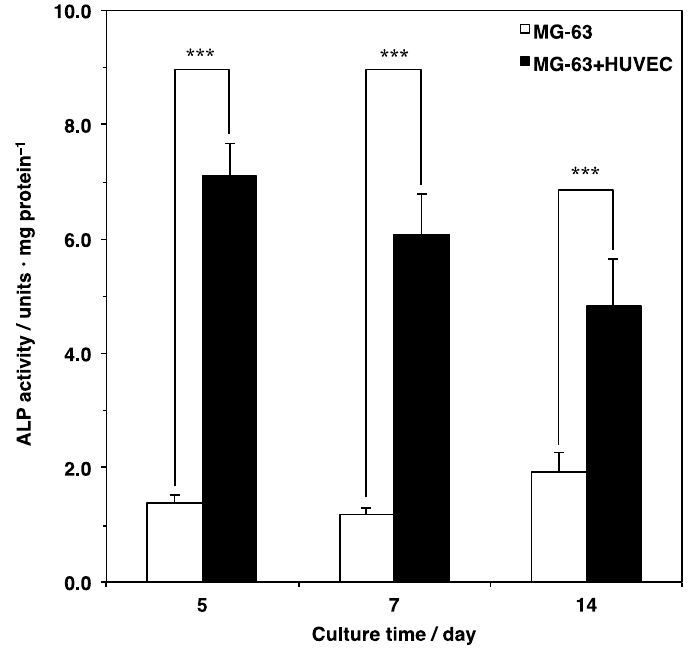
Figure 6. Comparison of ALP activity in a monoculture and a co-culture on a microfiber mesh scaffold. Cells were seeded at 5.0 × 10 5 cells cm –3 on the scaffold placed in each well of a 24-well plate and cultured for 5, 7, and 14 days. ALP activity was assessed using a p -nitrophenyl phosphate substrate assay described in Materials and Methods. Data were determined from three replicate samples, which are shown as mean ± SD. *** p < 0.001 compared with the monoculture (MG-63 cells alone).